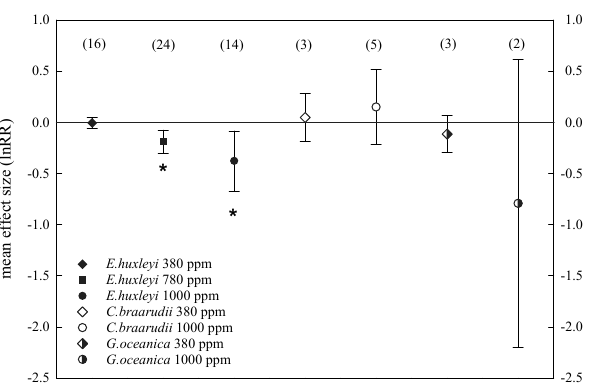
Figure 1. The effect of elevated CO 2 concentrations on the cal- cification rates of three coccolithophore species: Emiliania hux- leyi , Coccolithus braarudii and Gephyrocapsa oceanica (mean ef- fect size and 95% confidence interval). Responses are relative to 280 ppm. * indicates a significant response, which is given when the confidence interval does not overlap zero. The number of exper- iments used to calculate mean effect sizes are shown in parentheses. The zero line indicates no